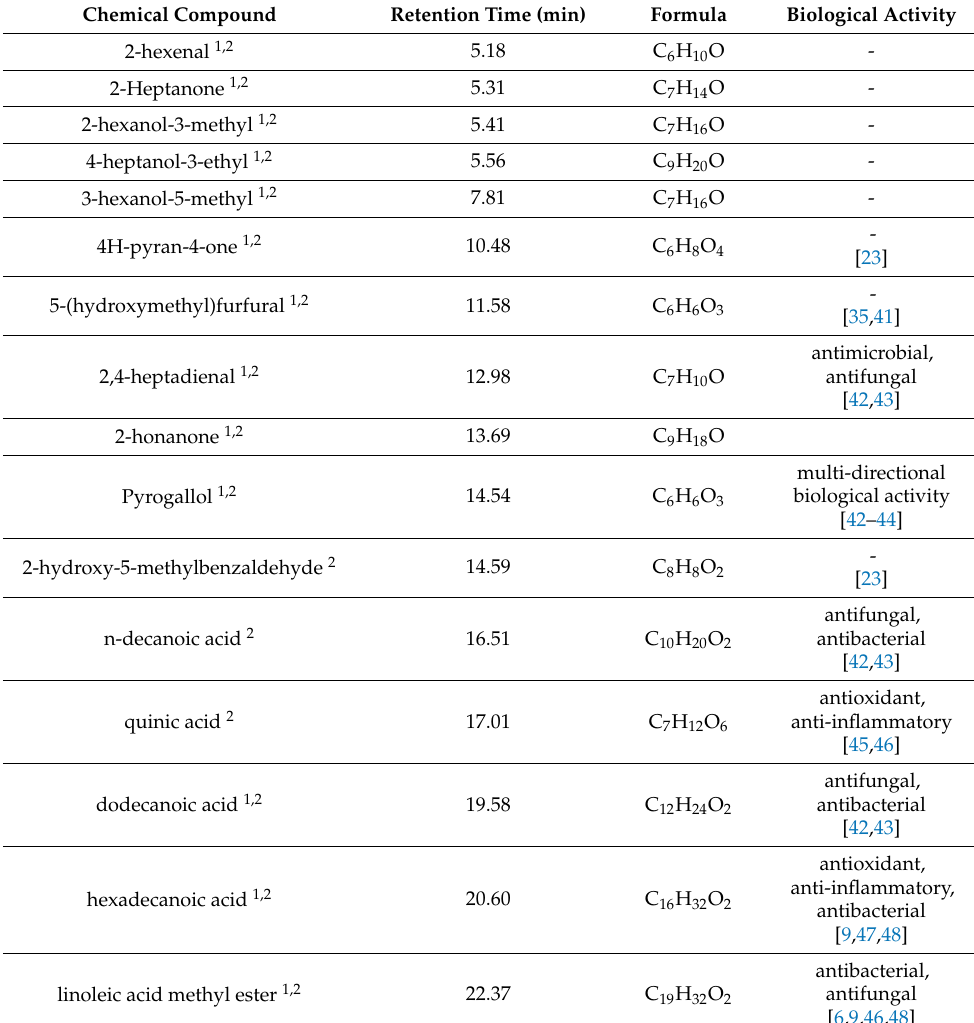
Table 1. The components of the preparations obtained from leaves of Rubus idaeus L. and Rubus fruticosus L. as determined by